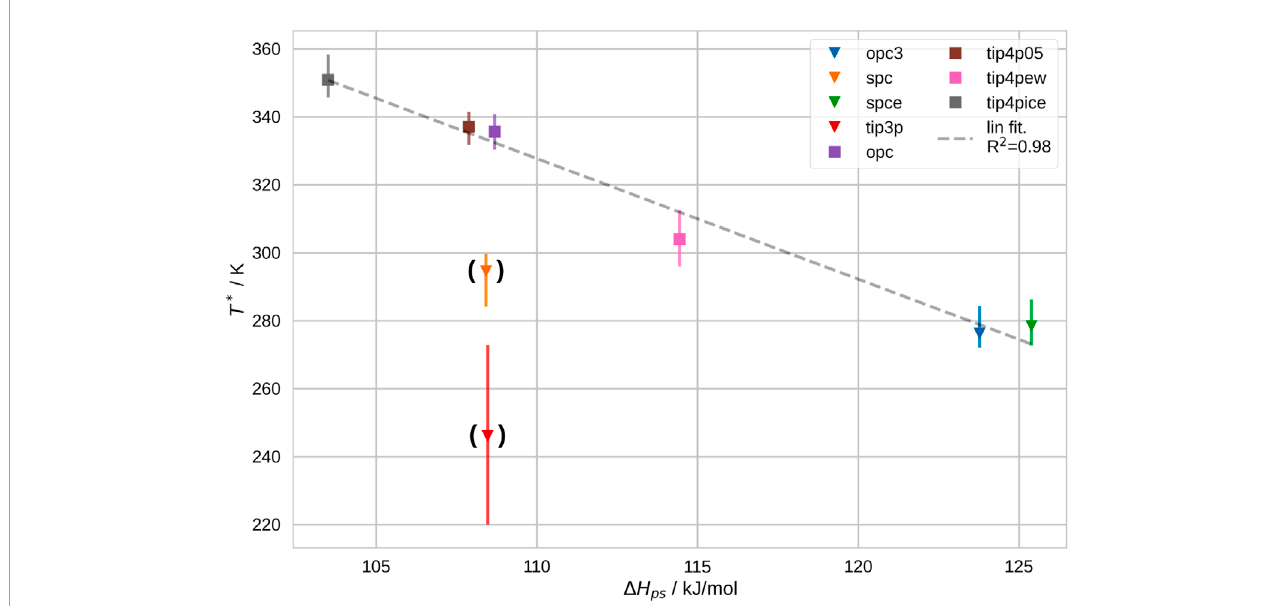
FIGURE 4 Difference between coil and globule states in interaction potential between polymer and solvent, Δ H ps , vs . T *. We show a dashed trend line for this correlation in grey. Two points–TIP3P and SPC–are not taken into account for this trend. These results correspond to infinite dilution. The here-shown values correspond to the mean change in potential energy between polymer and solvent, during the Coil-Globule transition of PNIPAM 20-mers in infinitely dilute solution.